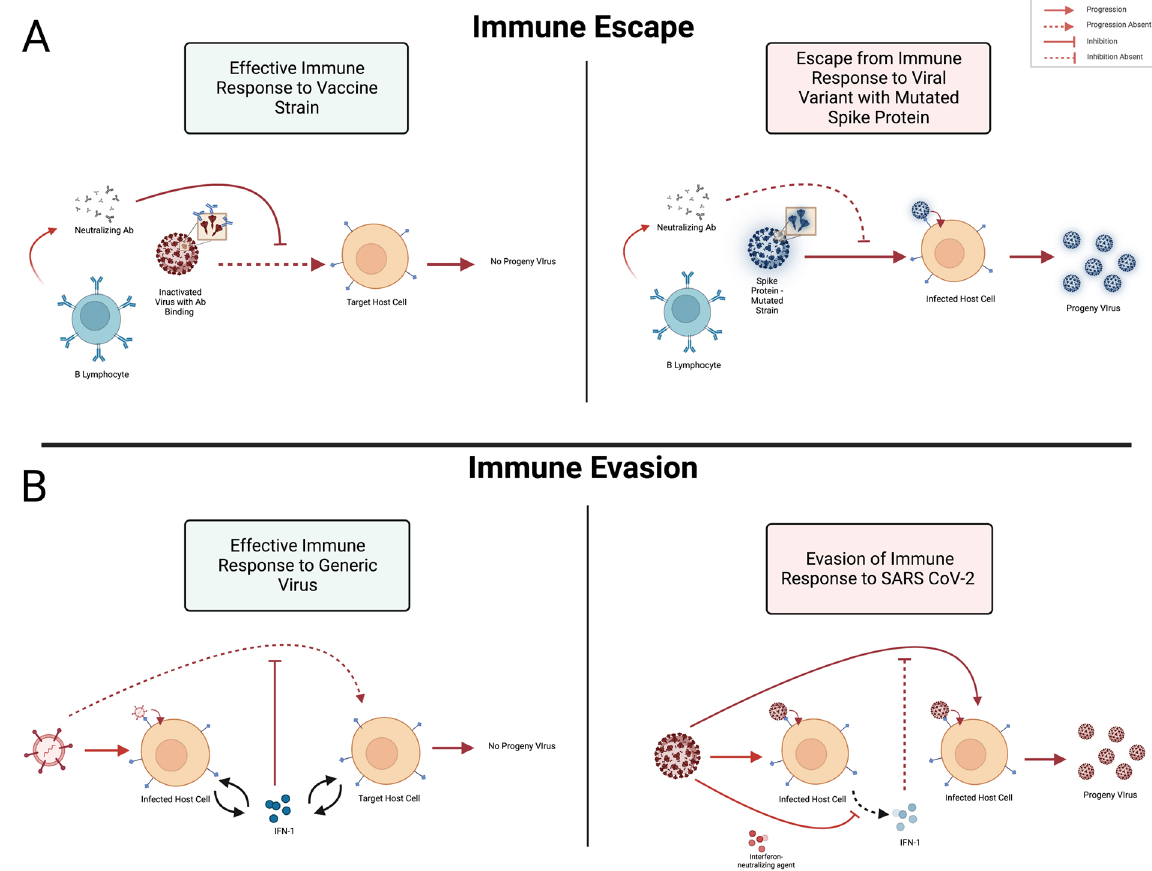
Figure 2. Schematic illustration of the key differences between the mechanisms of what we suggest corresponds to immune escape (top) versus what corresponds to immune evasion (bottom). Our view is that immune escape should refer to one or more mutations in the genome of a virus or other infectious agent that meaningfully decrease recognition of a key pathogen-associated antigen by antibodies or T-cell receptors. In contrast, immune evasion should correspond to the situation where 1 or more gene products encoded in the genome of the infectious agent function to inhibit or otherwise undermine relevant immunological processes of the host, thereby hindering clearance or destruction of that agent by those host mechanisms. The example of viral proteins that interfere with the production or functioning of type I interferons is used to illustrate the concept of immune